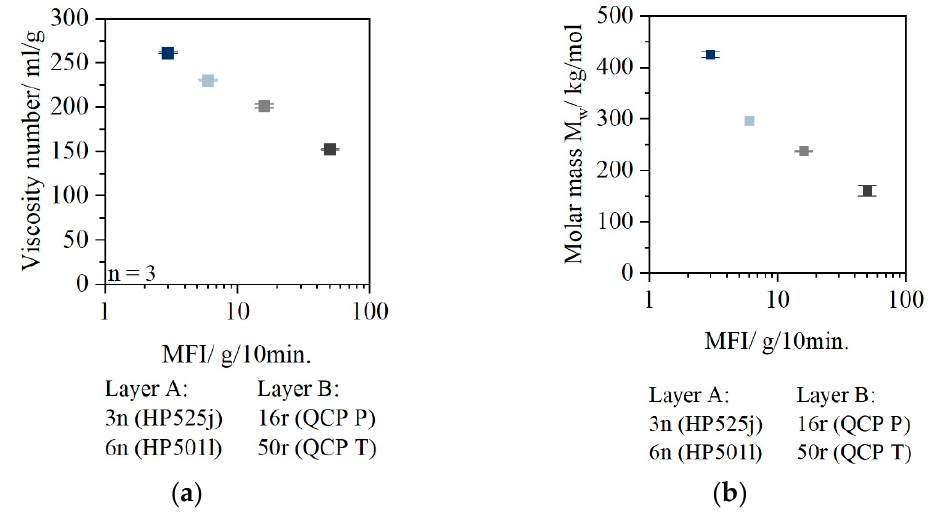
Figure 2. Calculation of the stress percentage after yield stress and thickness distribution after stretching. Figure 3. Viscosity number of the used materials [29] ( a ); molar mass ( b ). Figure 3. Viscosity number of the used materials [29] ( a ); molar mass ( b ). The viscosity numbers of 3n and 6n (VZ 3n : 250 mL/g and VZ 6n : 225 mL/g)